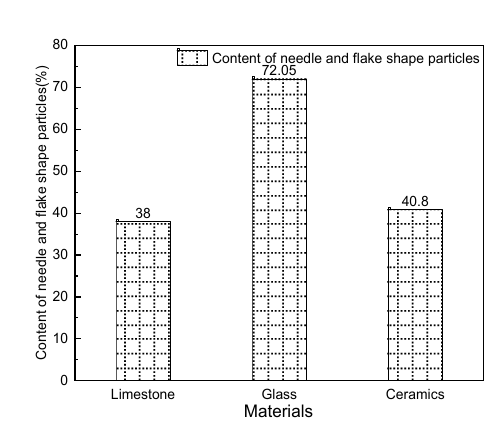
Figure 3. XRD results of ceramics.